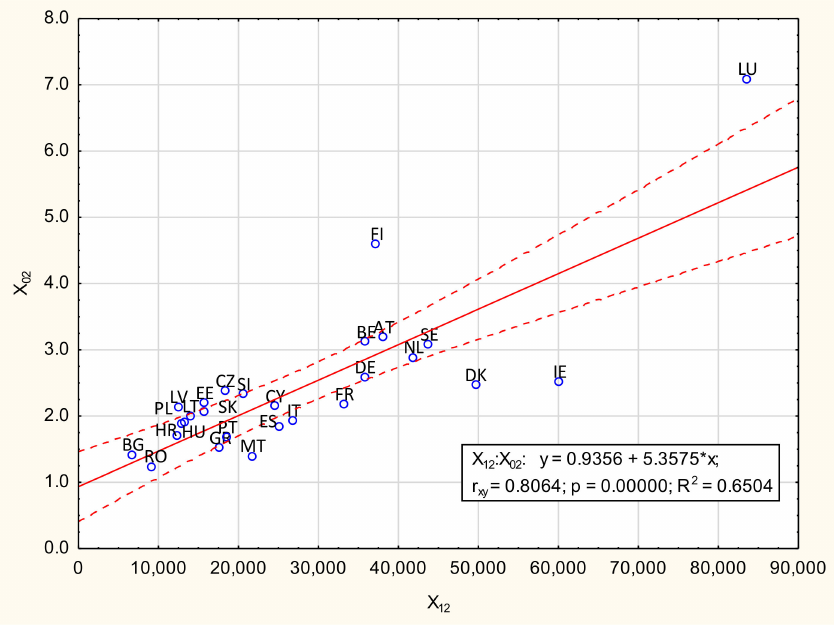
Figure 5. Correlation between final energy consumption and GDP per capita in EU (27) countries in 2019 (scatterplot for variables X 02 and X 12 ). Key: r xy —linear correlation coefficient; R 2 —coefficient of determination. Source: own work based on